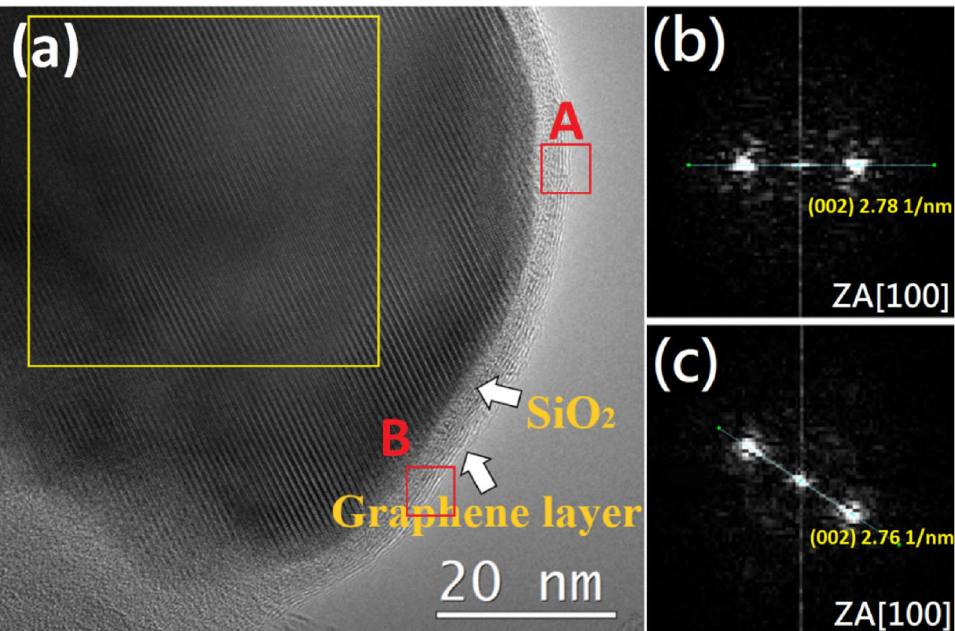
Figure 5. ( a ) The HRTEM image of the catalyst particles. ( b , c ) The selected area electron diffraction (SAED) images of the selected area marked by the red rectangle A and B respectively in ( a